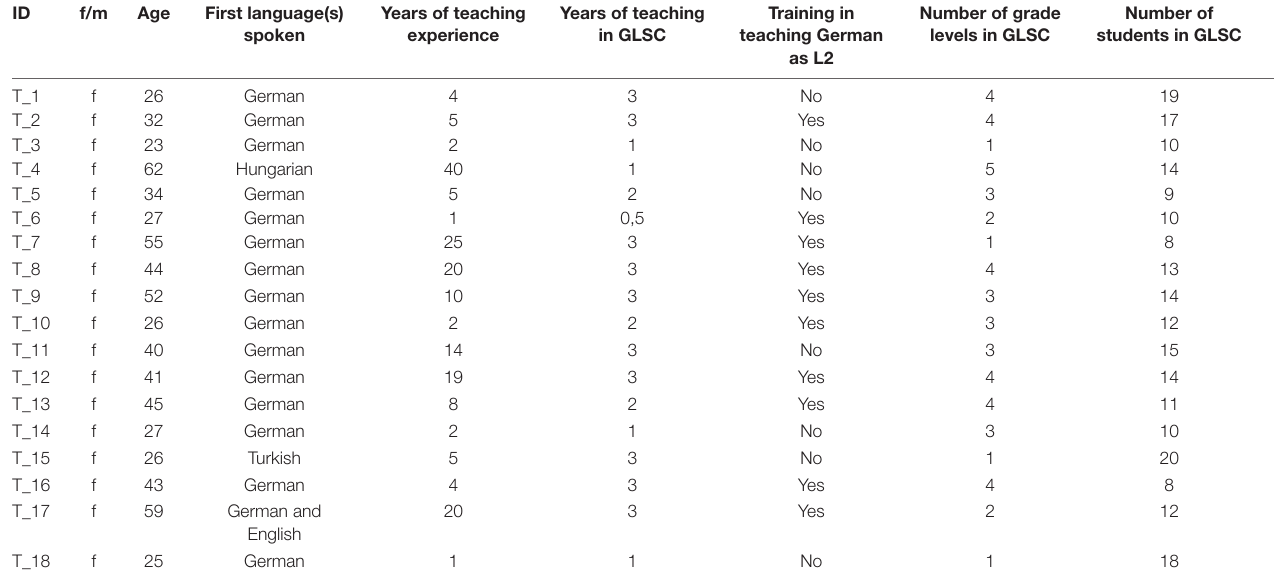
TABLE 1 | Sociodemographic characteristics of the 18